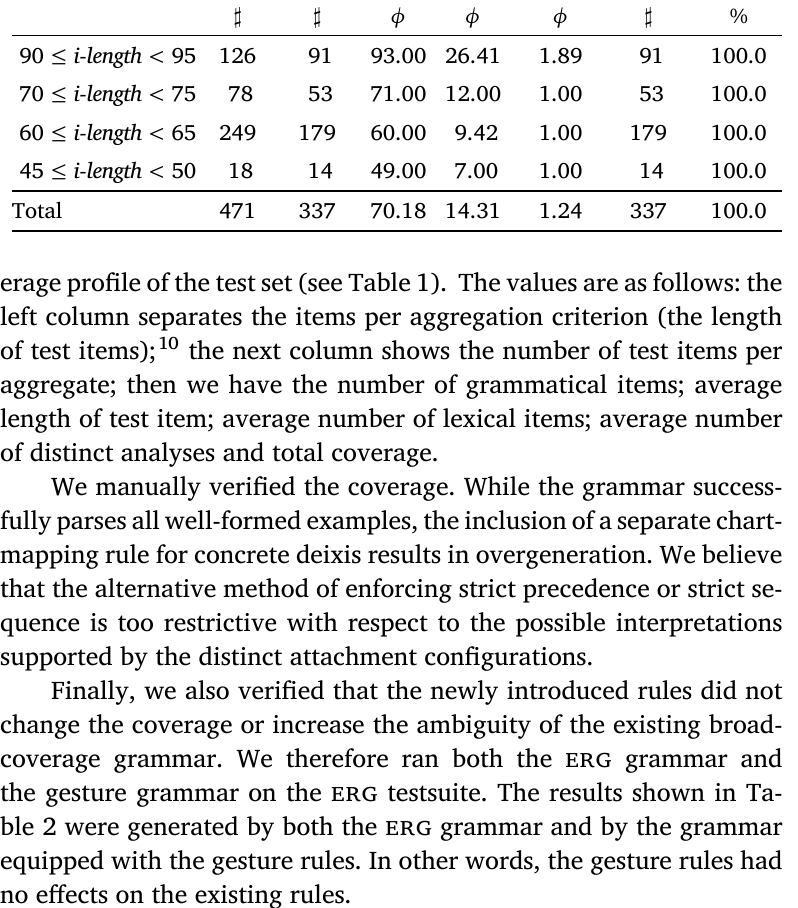
Table 1: Gesture grammar coverage